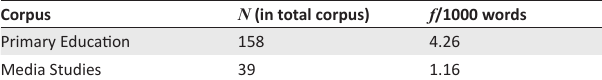
TABLE 2: Total number of reporting verbs and frequency of use per 1000 words ( f /1000).